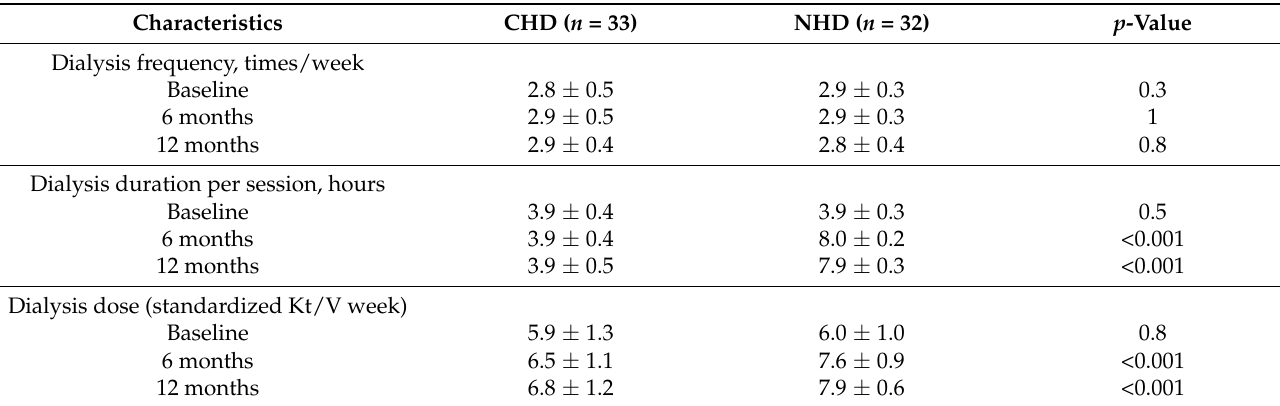
Table 2. Characteristics of dialysis